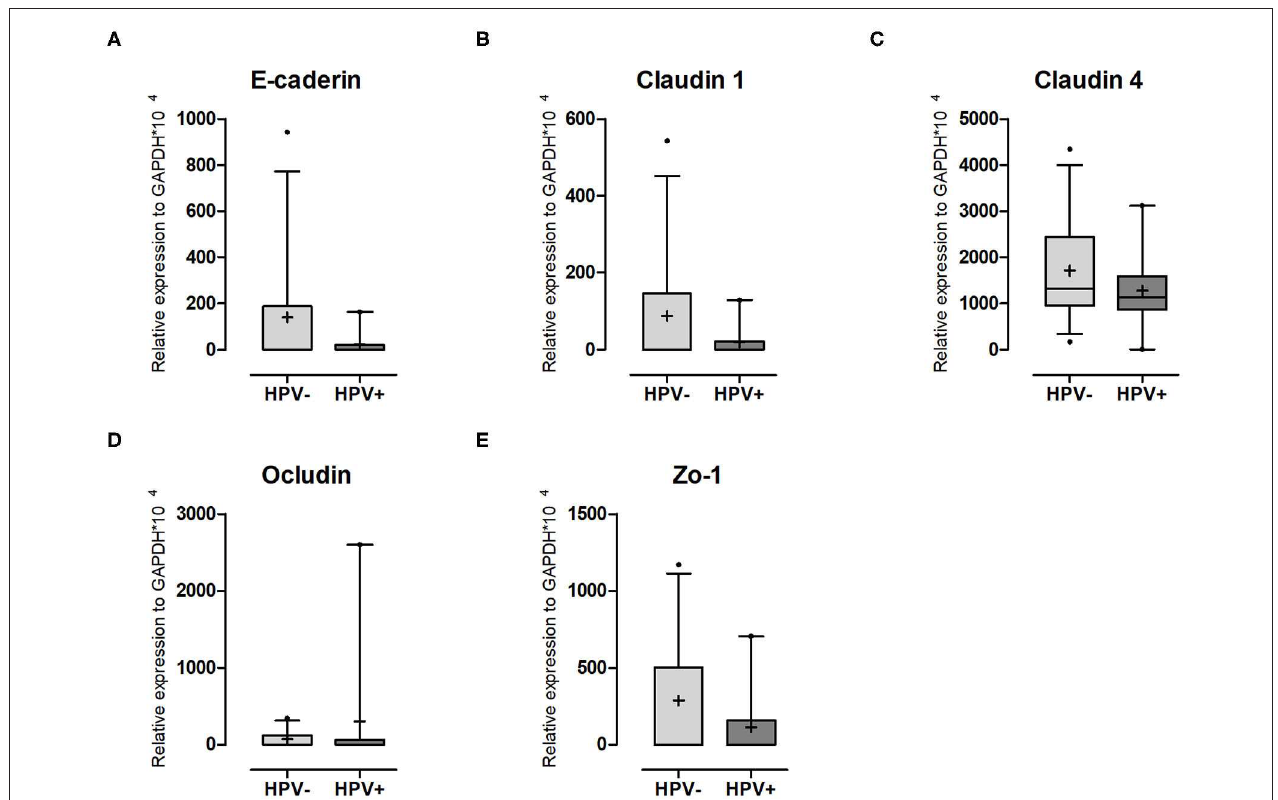
FIGURE 4 | Adhesion molecule expression in cervical cells. Expression levels of (A) E-caderin; (B) Claudin-1; (C) Claudin-4; (D) Ocludin and (E) ZO-1 relative to GAPDH expression. Box plots represent 10–90 percentiles; dots represent outlier samples; “ + ” represents the mean and the horizontal bar, the median. HPV- = 12 and HPV + = 9 women. Statistical test: Mann-Whitney U